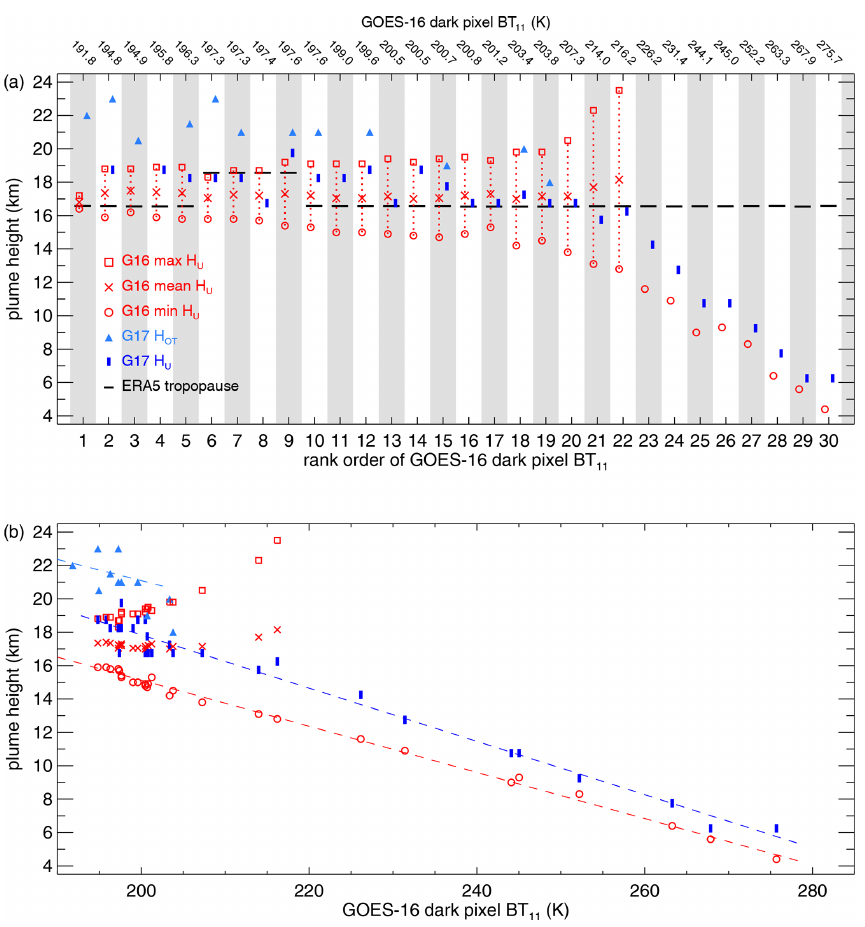
Figure 15. Comparison of GOES-17 side view heights (blue) and GOES-16 temperature-based heights (red) as a function of GOES-16 dark pixel BT 11 : (a) rank order and (b) absolute value. H U and H OT are the heights of the umbrella and the overshooting top, respectively; H OT is only estimated from GOES-17. The height of the ERA5 cold point tropopause is also indicated. In panel (b) , the dashed lines are linear fits to the GOES-17 umbrella and OT heights (cases 15, 18, 19 are excluded for